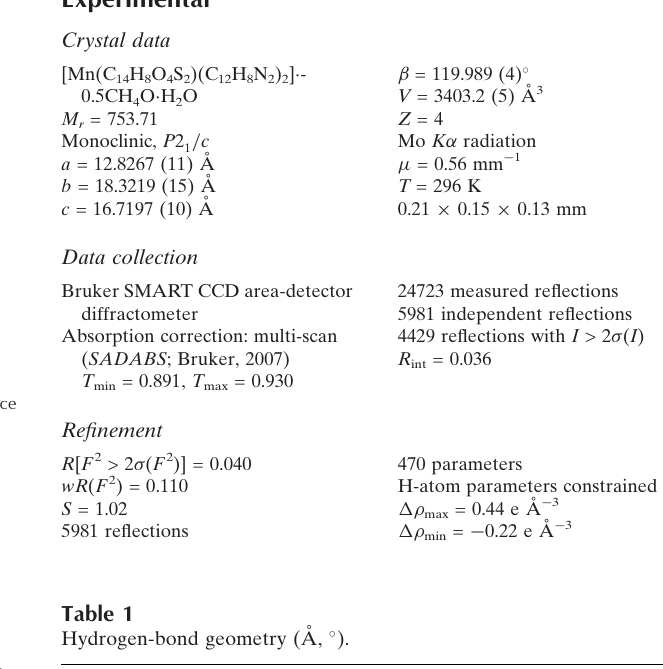
Key indicators: single-crystal X-ray study; T = 296 K; mean (cid:2) (C–C) = 0.005 A˚; disorder in solvent or counterion; R factor = 0.040; wR factor = 0.110; data-to- parameter ratio = 12.7.